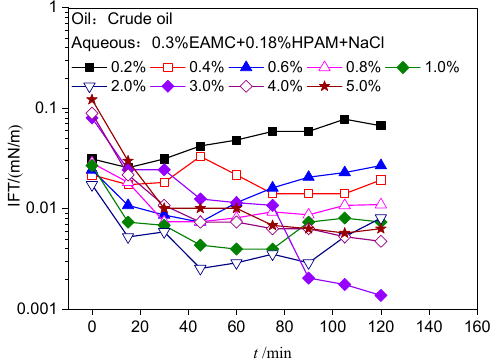
Figure 3. The effect of NaCl on the dynamic IFTs of EAMC and HPAM solutions. The concentration of NaCl is represented by lines with different colors and shapes. The Alkali Tolerance of EAMC and HPAM Solutions The alkali tolerance of 0.3 wt % EAMC and 0.18 wt % HPAM solution was also in- vestigated and the experimental results are plotted in Figure 4. We can see from Figure 4 that ultralow IFT values appear when Na 2 CO 3 has been added with a concentration range from 0.4 wt % to 1.4 wt %. This indicates the surface-active substances produced by the reaction of alkali and petroleum acids show synergism with EAMC in reducing IFT.